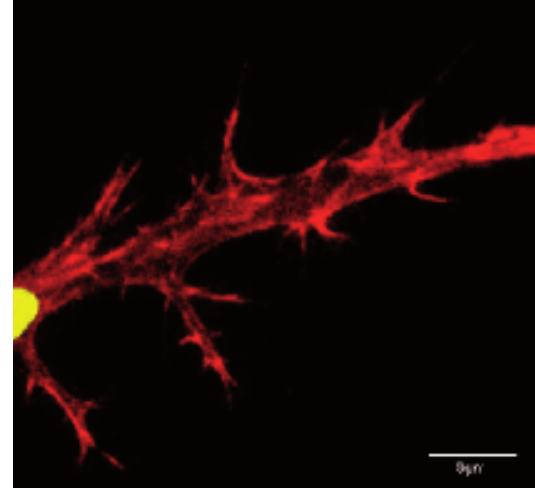
Figure 1 Human dermal fibroblasts were observed to spread in three dimensions in matrix metallo- proteinase-sensitive hydrogels in a pro- tease-dependent manner. The spatial fidelity of degrada- tion of the surround- ing gel material was very high. Here, small philopodia can be observed, with diameters in the order of 1 µm, penetrating the gel by local, cell-induced proteolysis. (Photo: G. P. Raeber and M. P.